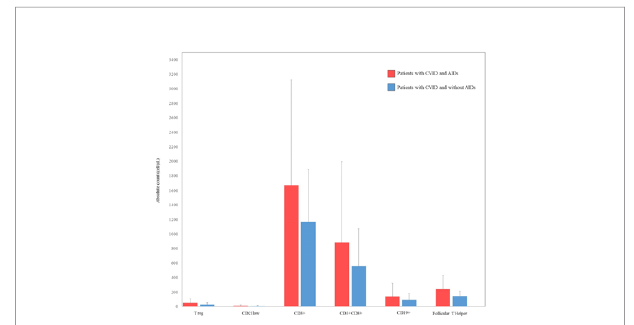
FIGURE 2 | Comparisonbetweenlymphocytecountsubsetsatdiagnosisinour cohort ofpatientswithcommonvariableimmunode fi ciency(CVID)andautoimmune